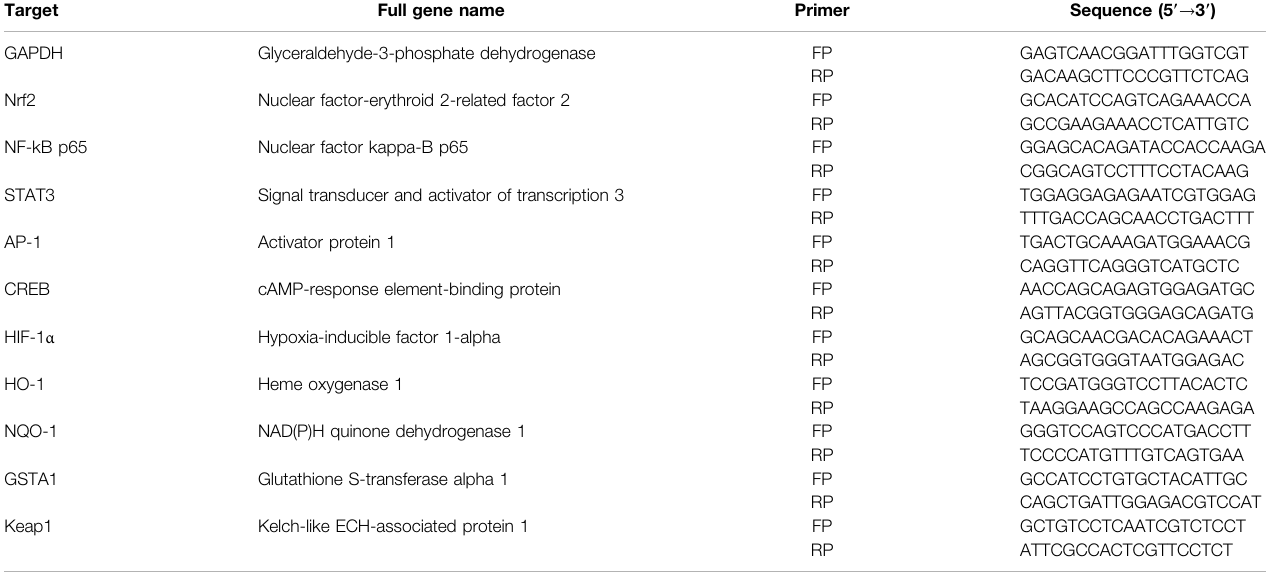
TABLE 1 | List of primers for real-time polymerase chain reaction